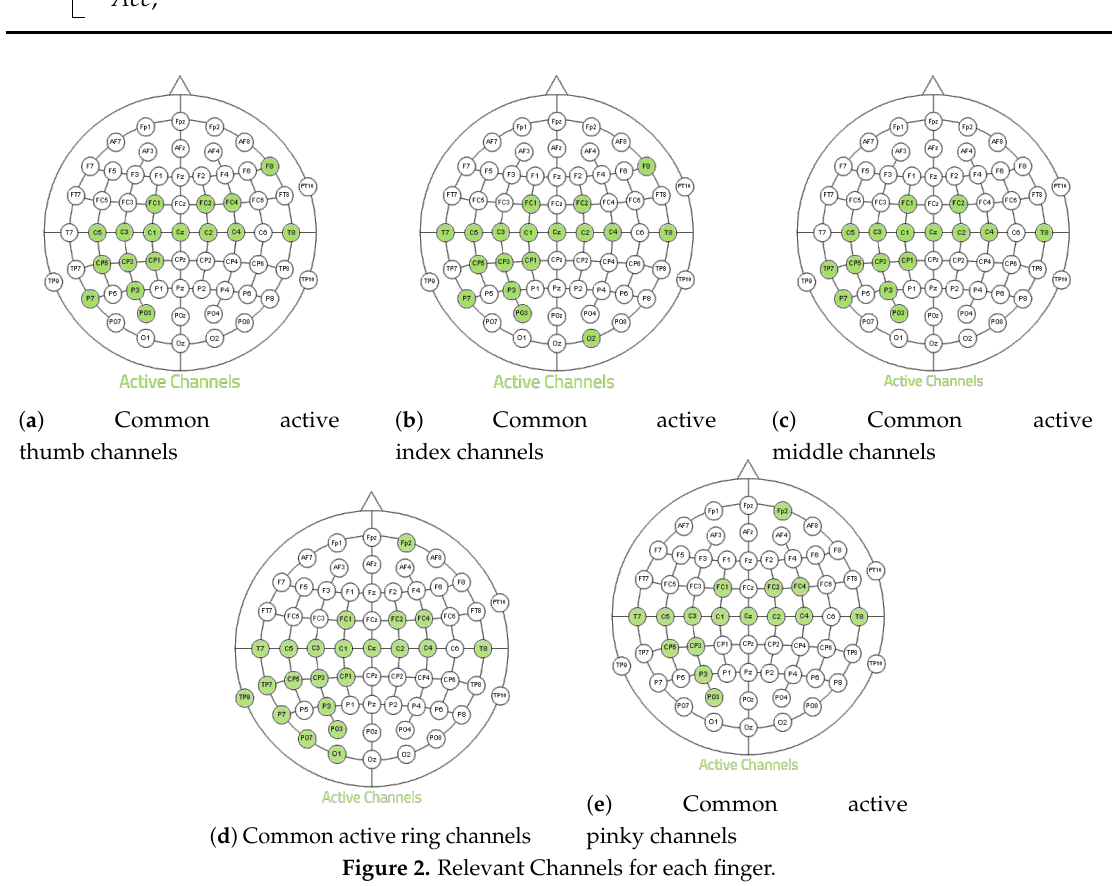
Figure 2. Relevant Channels for each